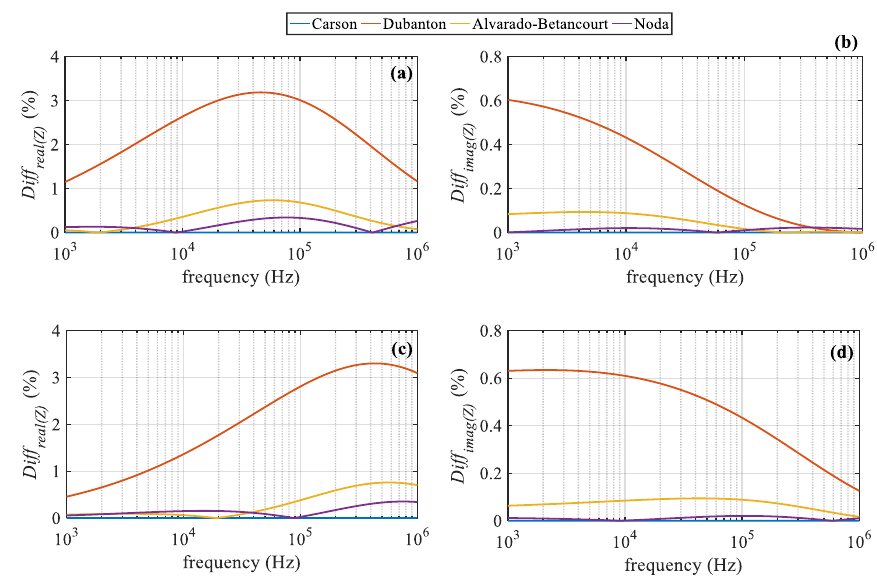
Figure 5. Di ff erences in Z 11 in NB. For ρ g = 100 Ω m, ε rg = 1, ( a ) real part and ( b ) imaginary part, Figure 5. Differences in Z 11 in NB. F or ρ g = 100 Ωm, ε rg = 1, ( a ) real part and ( b ) imaginary part, for ρ g for ρ g = 1000 Ω m, ε rg = 1, ( c ) real part and ( d ) imaginary part. Energies 2020 , 12 , x FOR PEER REVIEW